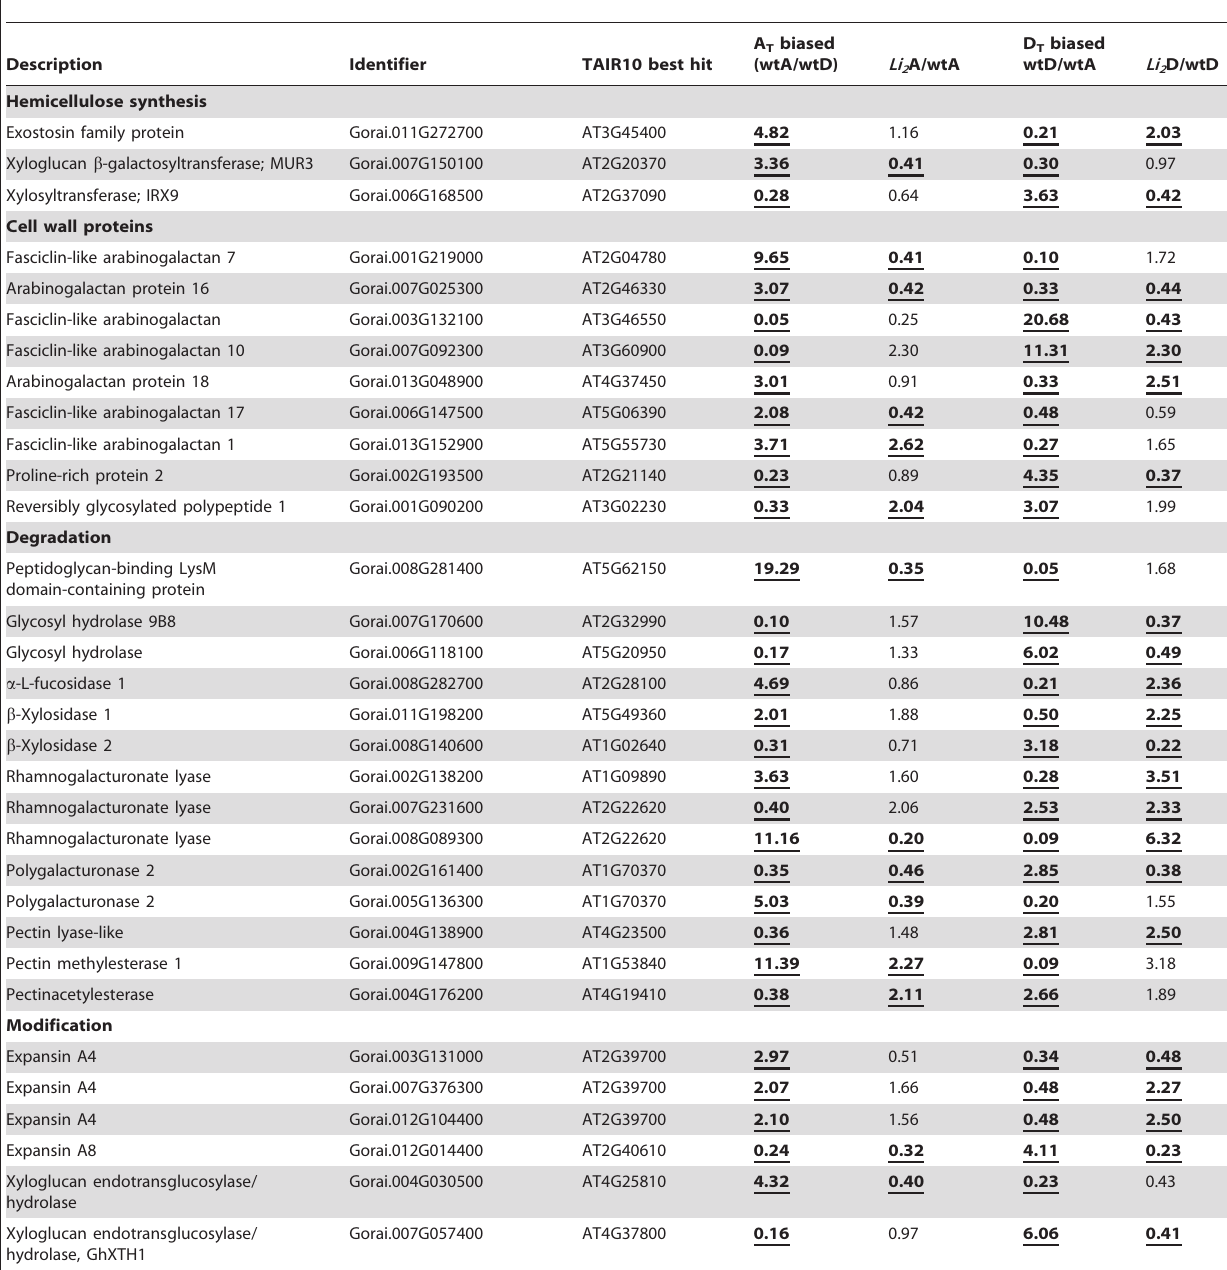
Table 4. Subgenome biased genes encoding enzyme involved in cell wall biosynthesis changed expression level as a result of Li 2